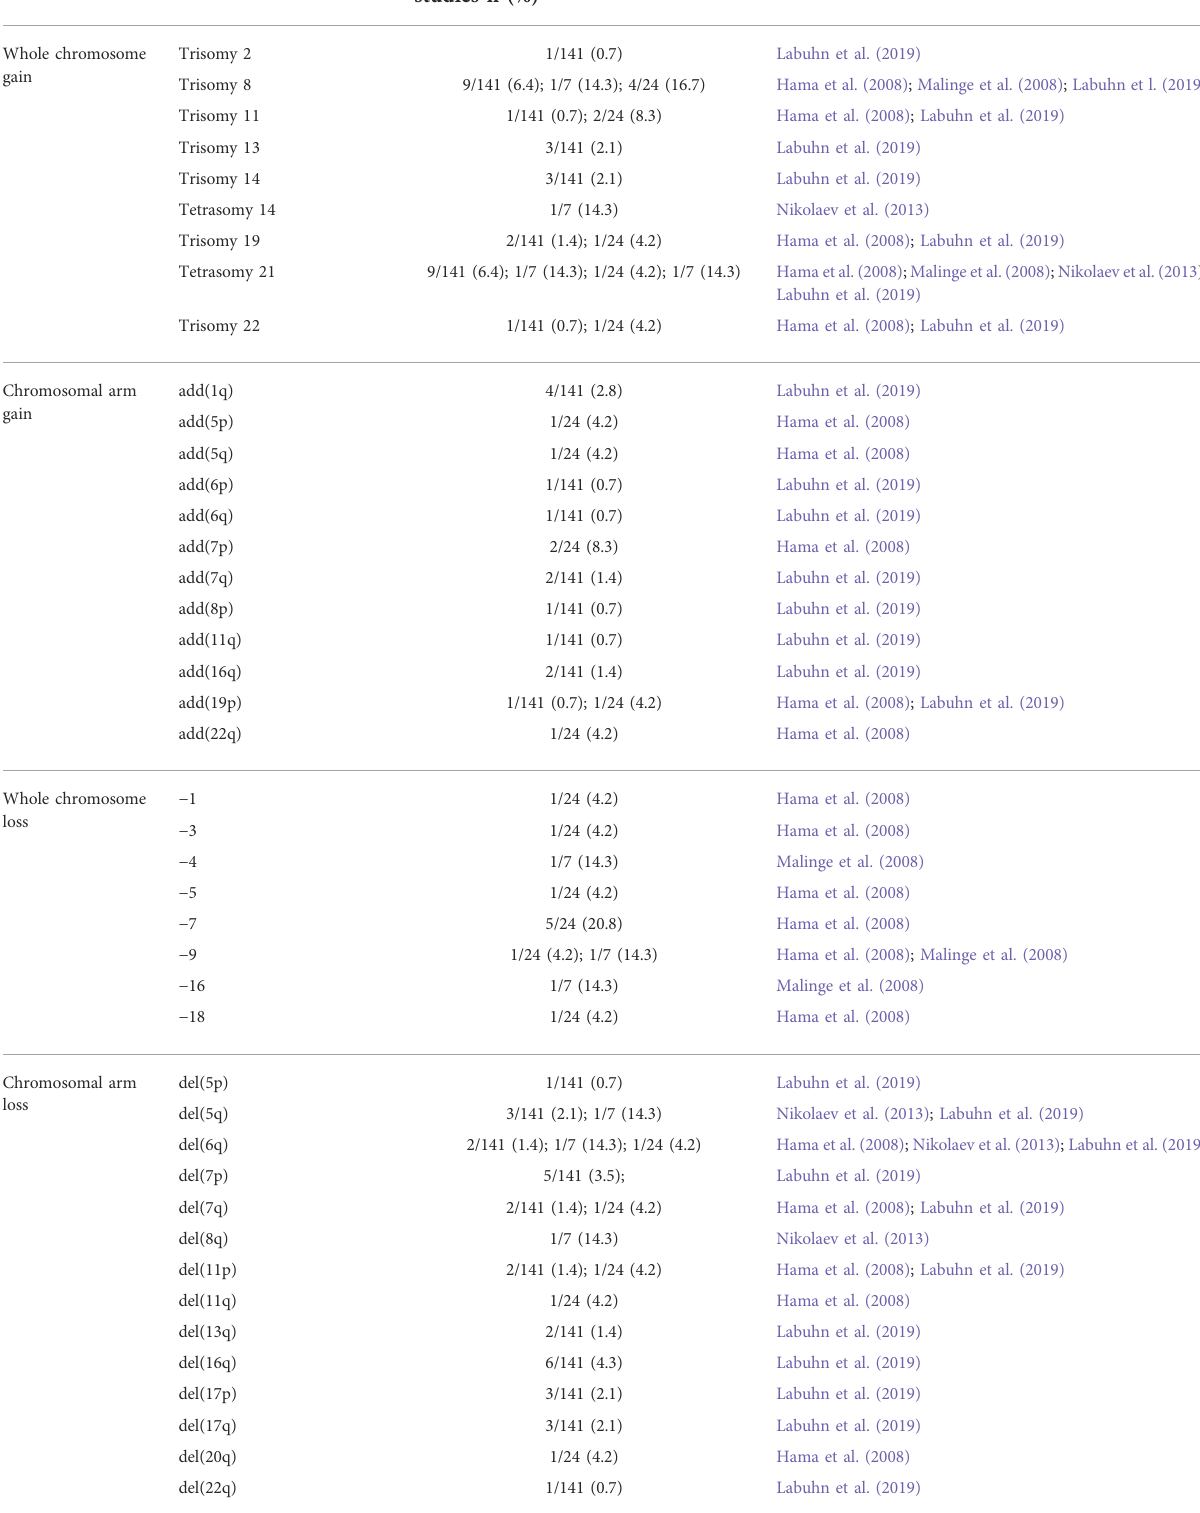
TABLE 3 Chromosomal abnormalities reported in myeloid leukemia associated with Down